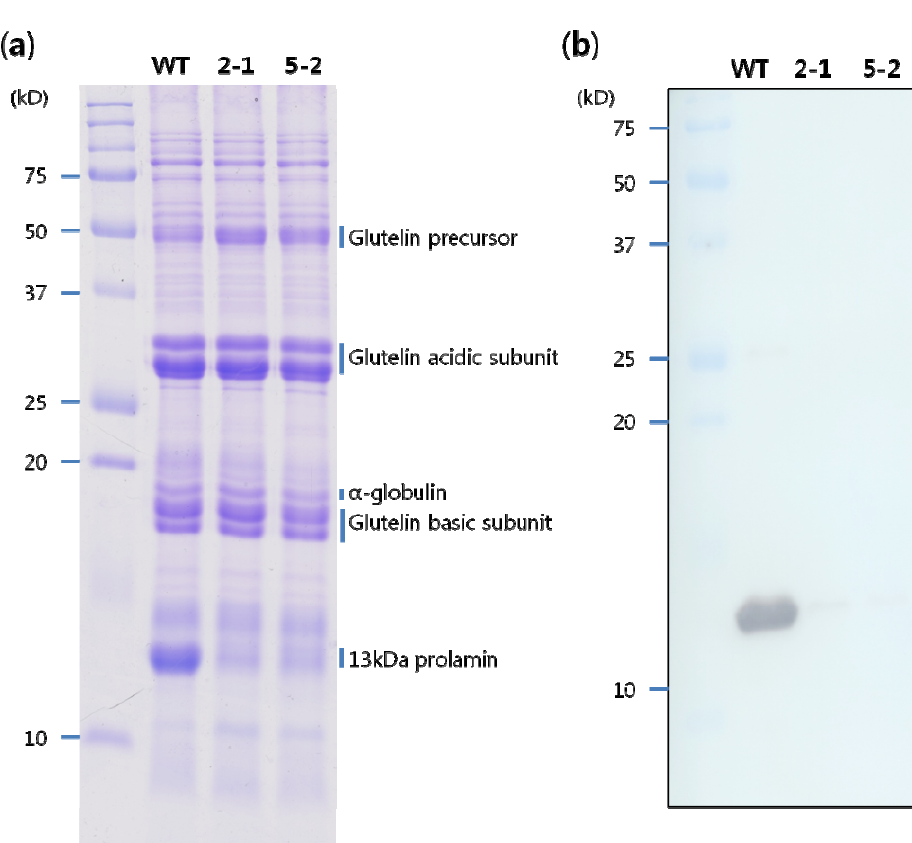
Figure 2. Accumulation of seed storage proteins in mature seeds, ( a ) SDS-PAGE analysis. Total proteins extracted from mature seeds of the wild type (WT) and 13 kD pro-RNAi lines (2-1 and 5-2, respectively) were separated on a 15% SDS-PAGE gel and stained with coomassie brilliant blue (CBB); ( b ) Western blot analysis of 13 kD prolamin. Seed storage proteins resolved by SDS-PAGE were transferred to a polyvinylidenefluoride (PVDF) membrane and incubated with 13 kD prolamin